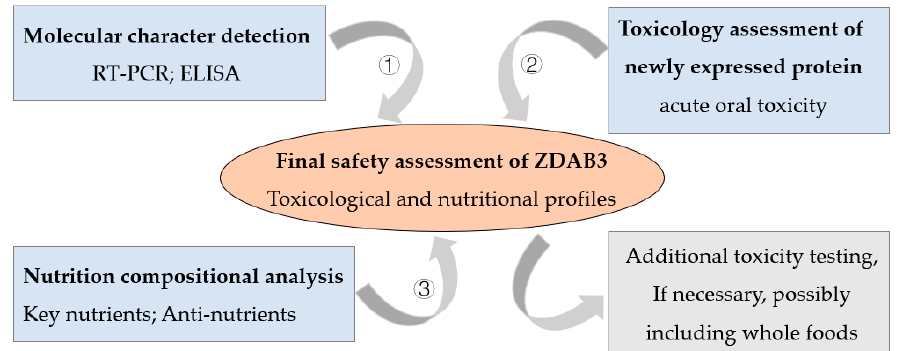
Figure 1. Safety assessment process of ZDAB3 in this study.